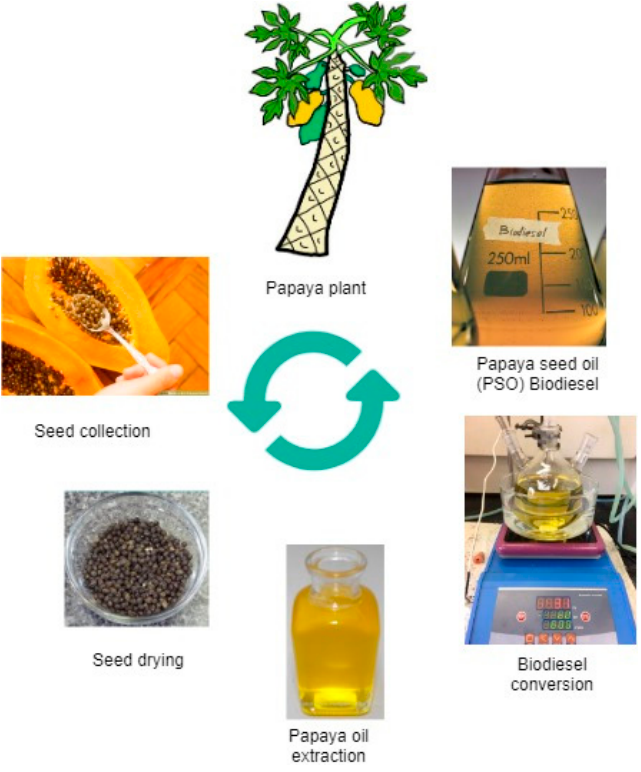
Figure 1. PSO biodiesel production.